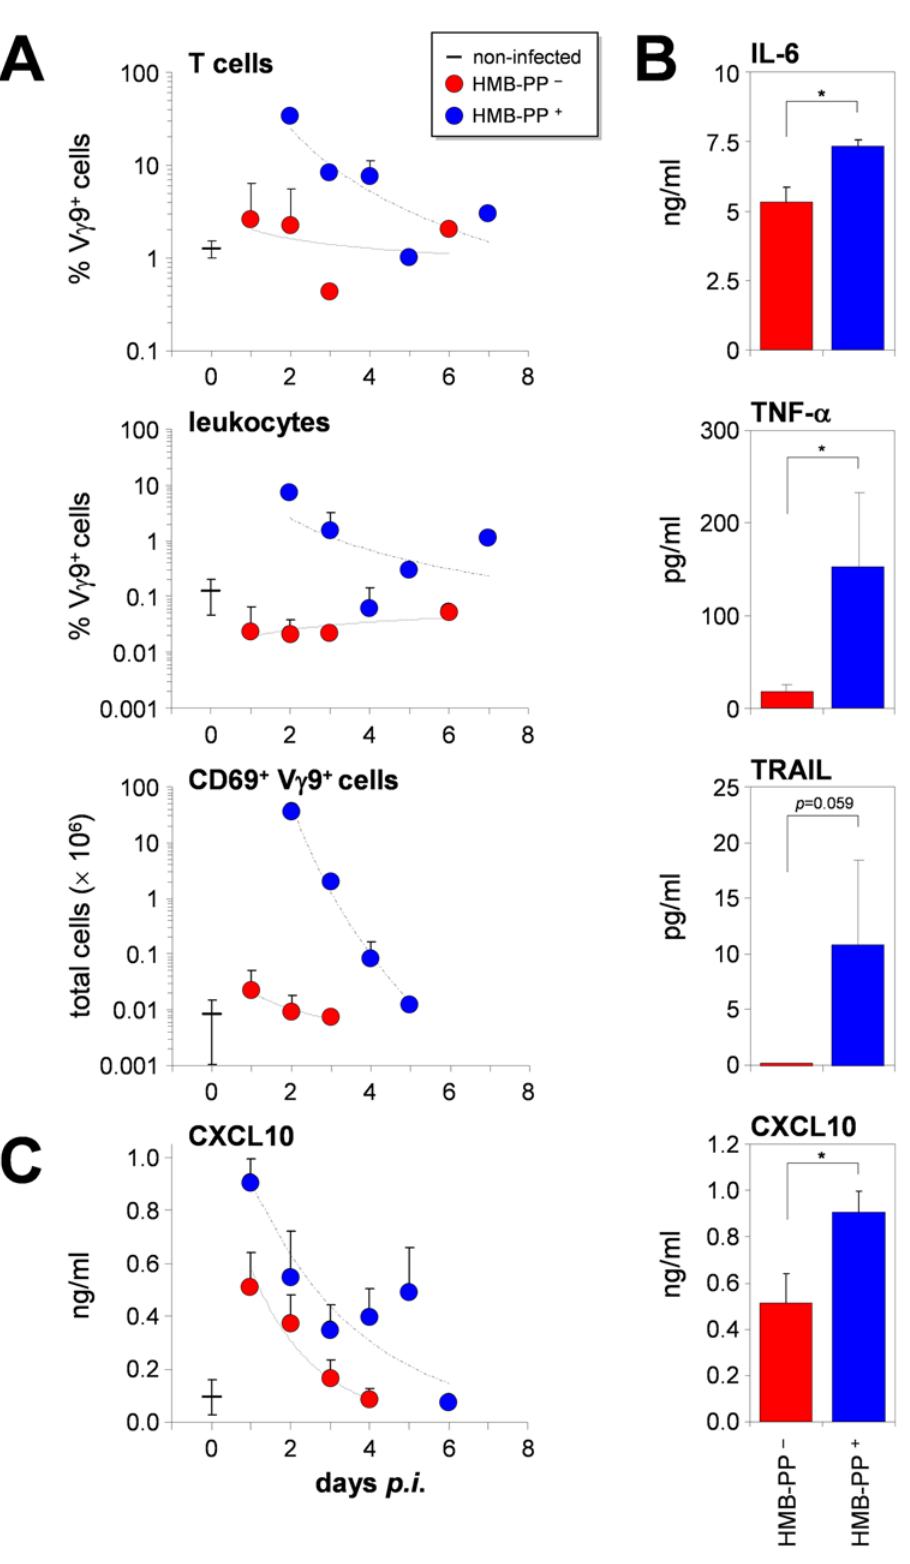
Figure 8. Peritoneal V c 9/V d 2 T cells and V c 9/V d 2 T cell-induced proteins are increased in HMB-PP + peritonitis. ( A ) Frequencies of V c 9 + T cells among CD3 + lymphocytes (top panel) and total leukocytes (middle panel), and absolute numbers of CD69 + V c 9 + T cells (bottom panel), as determined in non-infected individuals ( n =5–7), and patients with HMB-PP + ( Bacteroides splanchnicus , E. coli , Leclercia adecarboxylata , Proteus vulgaris ) ( n =5) or HMB-PP 2 peritonitis ( Staphylococcus epidermidis , a -hemolytic Streptococcus spp. ) ( n =8–13). ( B ) Peritoneal cytokine levels 6 SEM on day 1 p.i. , and ( C ) time course of CXCL10 levels over 6 days p.i. in cell-free effluent fluid from patients with HMB-PP + ( E. coli , Neisseria sp. , Proteus sp. , Pseudomonas sp. , unspecified coliform and coryneform bacteria) ( n =7–10) or HMB-PP 2 peritonitis ( Staphylococcus aureus , Staphylococcus epidermidis , a -hemolytic Streptococcus spp. ) ( n =13–16).